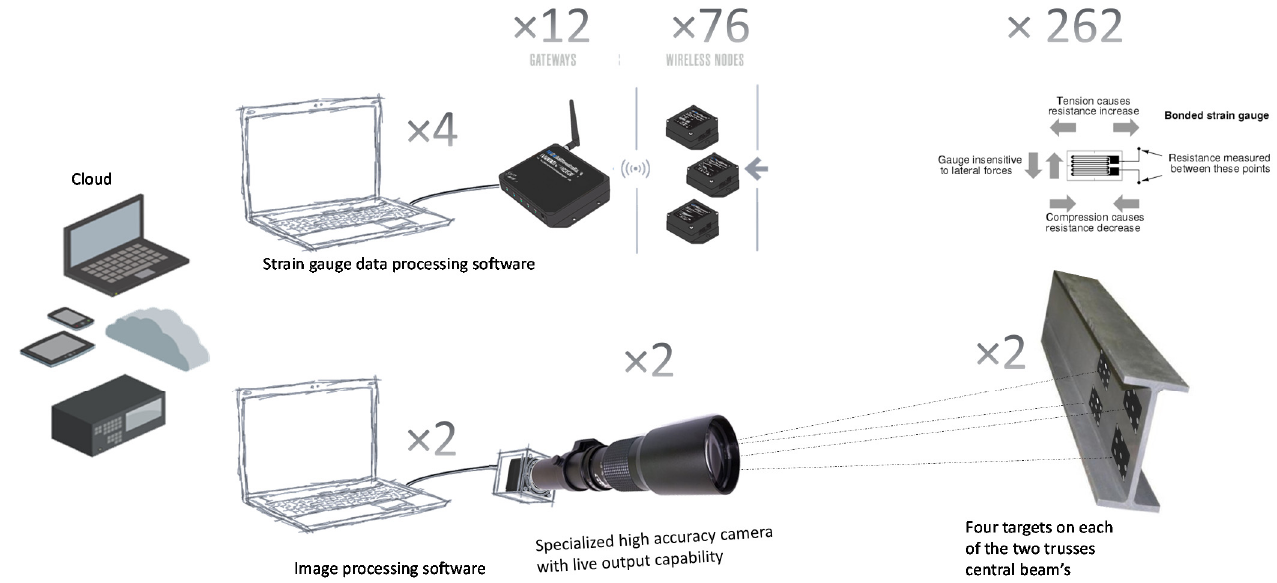
Figure 2. Industrial Internet of Things structure.